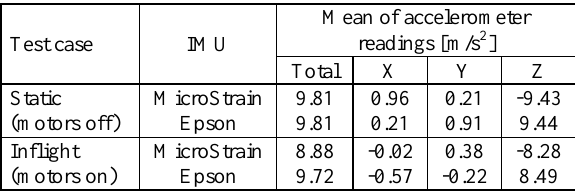
Table 5. Analysis of accelerometer readings for the flight with